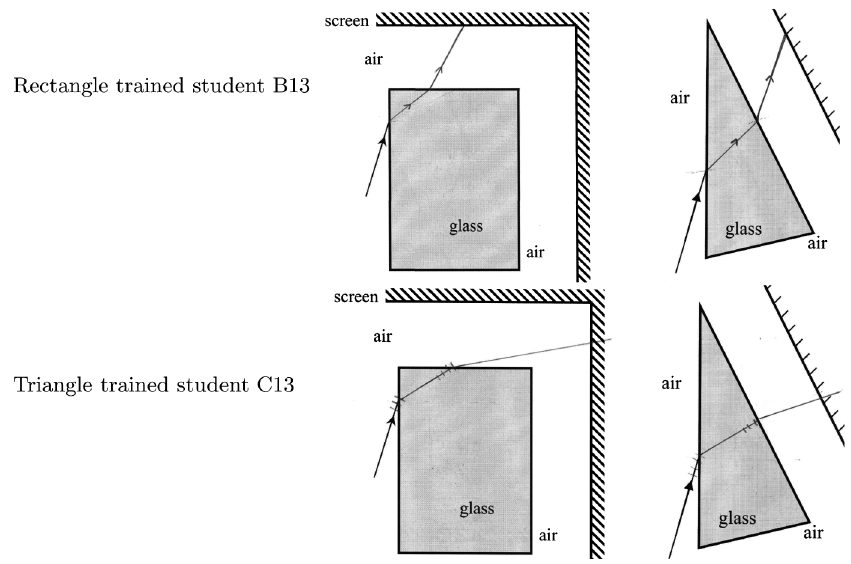
FIG. 4. Two participants’ responses to test questions 1 and